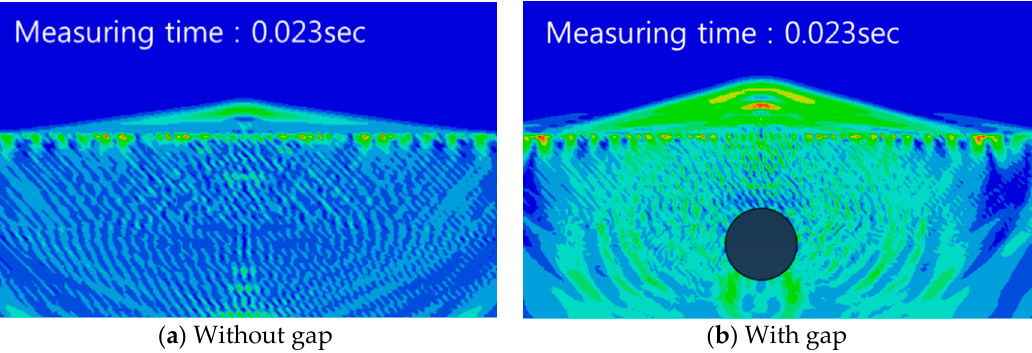
Figure 8. Acceleration contours generated in the concrete slab and in the air. ( a ) Without gap. ( b ) With gap.